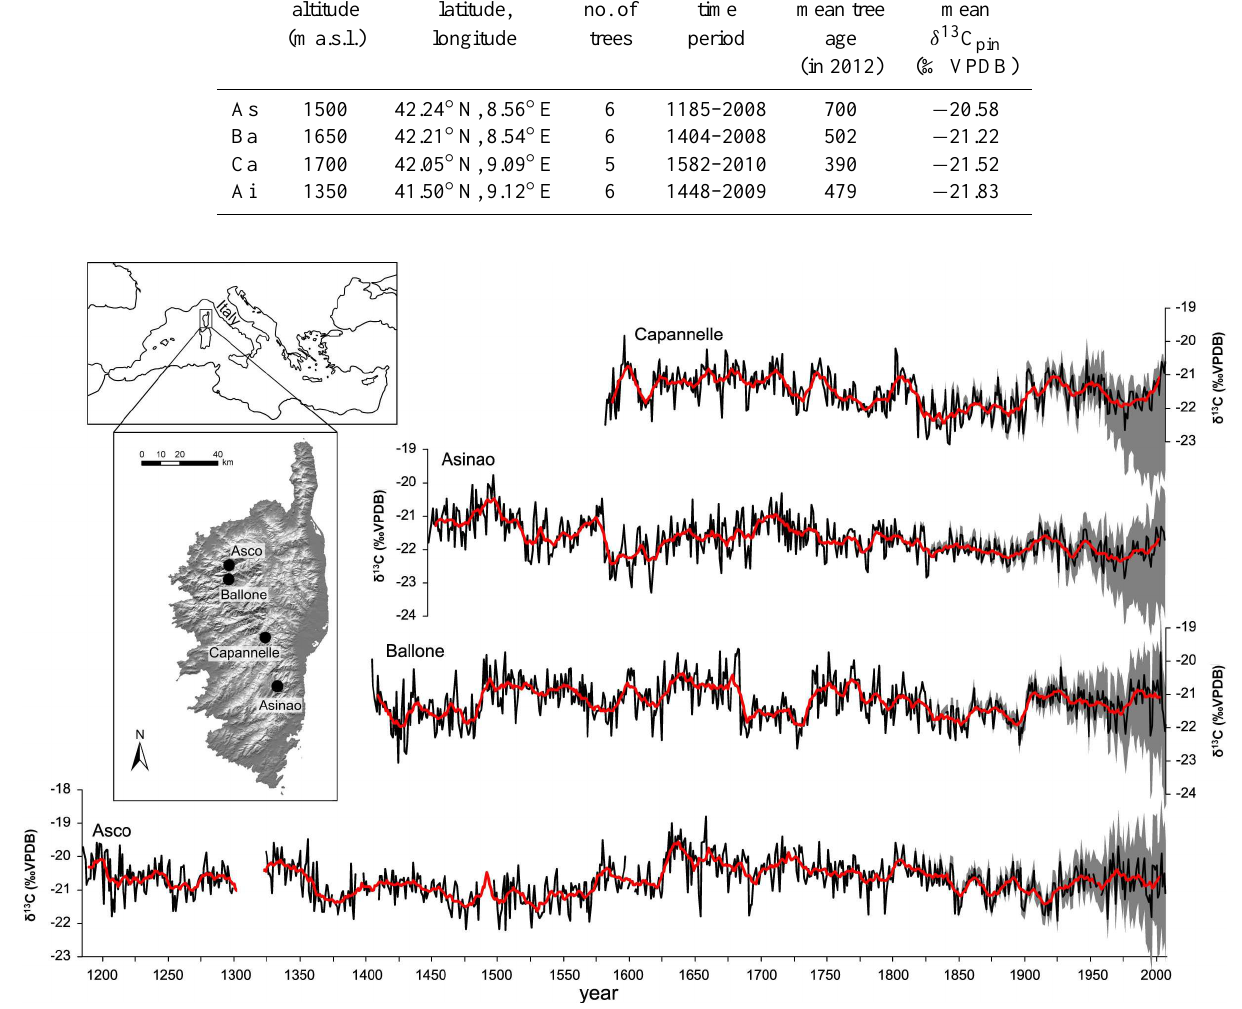
Fig. 1. Annually resolved carbon isotope chronologies for four mountain sites on Corsica. Isotope chronologies were corrected for changes in atmospheric CO 2 concentration and for plant physiological responses with the pin-correction (McCarroll et al., 2009). Grey shaded areas illustrate the range of isotope values corrected with different correction factors. Lower limit: raw uncorrected values, upper limit: corrected with the correction factor from Feng and Epstein (1995). Studies locations are marked on the map (left panel), small map shows the location of Corsica in the Mediterranean